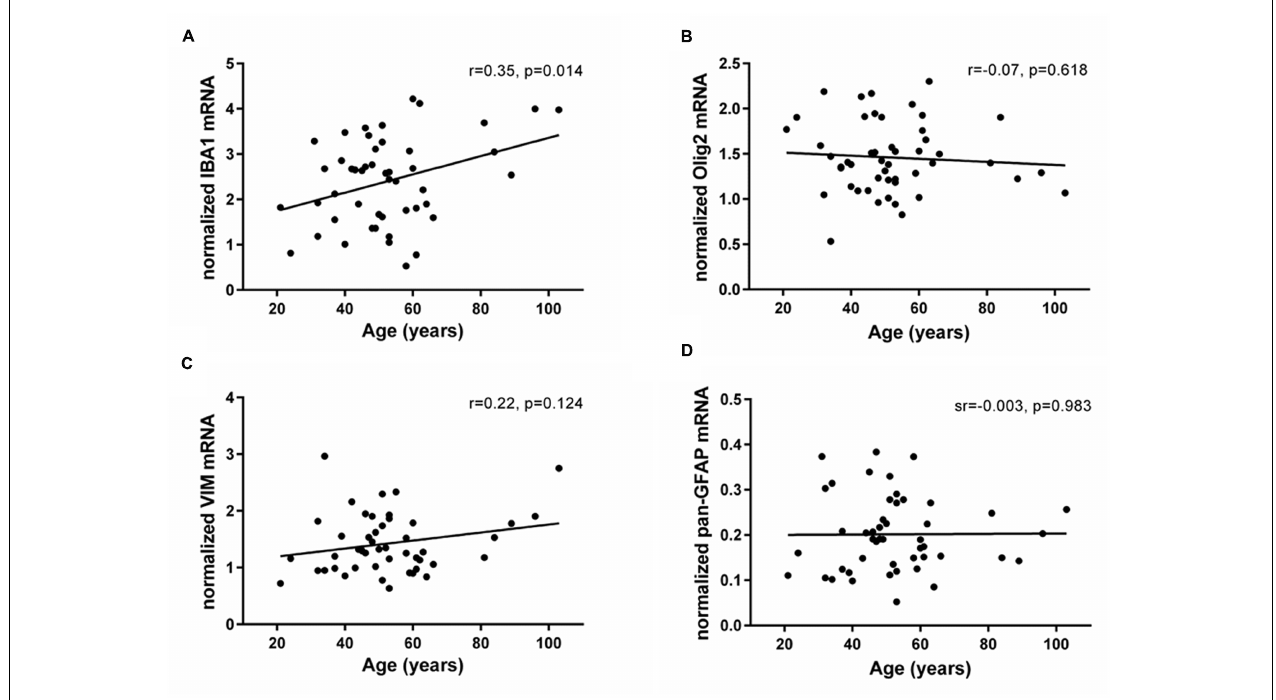
FIGURE 3 | Expression of glial cell markers in the human SEZ during aging. Transcript levels of microglia (IBA1), oligodendrocytes (Olig2), immature astrocytes (VIM) and mature astrocytes (pan-GFAP) were assessed by qRT-PCR and normalized to the geometric mean of two housekeeping genes. IBA1 expression (A) significantly increased throughout adulthood, while Olig2 (B) , VIM (C), and pan-GFAP mRNAs (D) were unchanged during aging. r, Pearson’s product-moment correlation coefficient; sr, semi-partial correlation